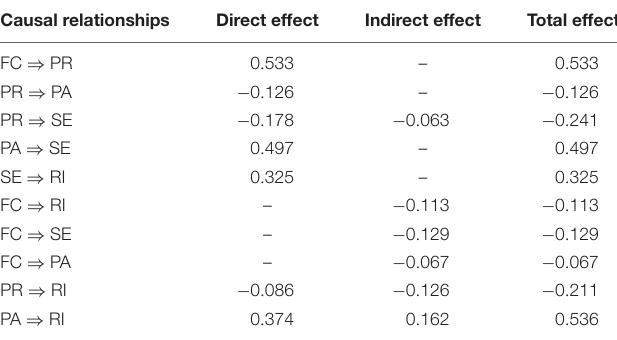
TABLE 5 | Results of mediation